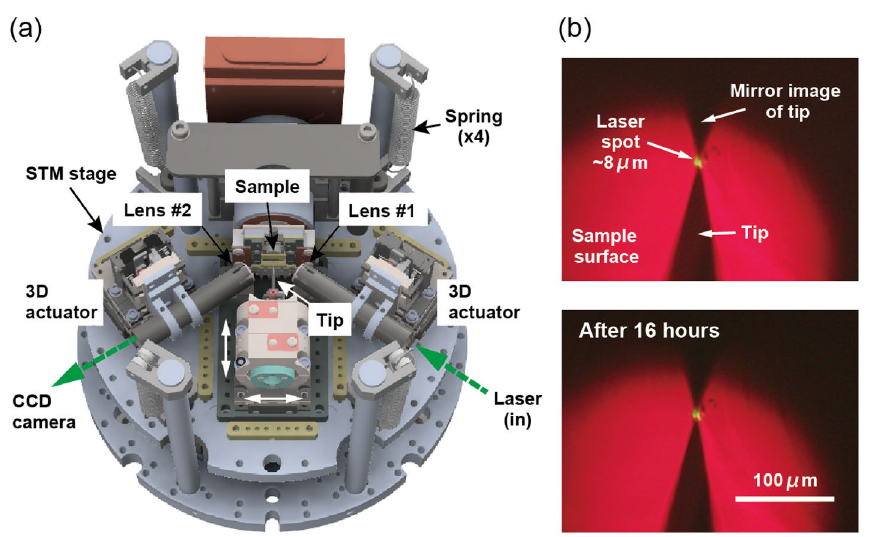
Figure 3. ( a ) Three-dimensional illustration of the STM unit (top-view). Electrical wirings and copper heat links are not shown for clarity. ( b ) (Top) Optical image of the tip and its mirror image on GaAs(110) surface with a laser spot illuminated at the tunneling junction. (Bottom) The image taken after 16 hours, showing the stability of the laser